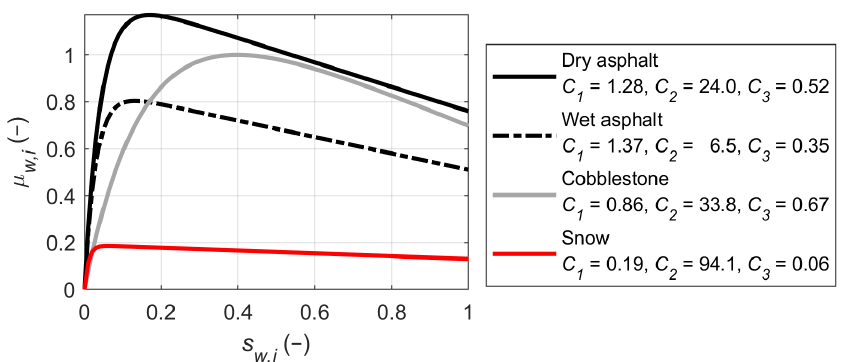
Figure 1. Sample tire curves and corresponding model parameters for different road surfaces and conditions